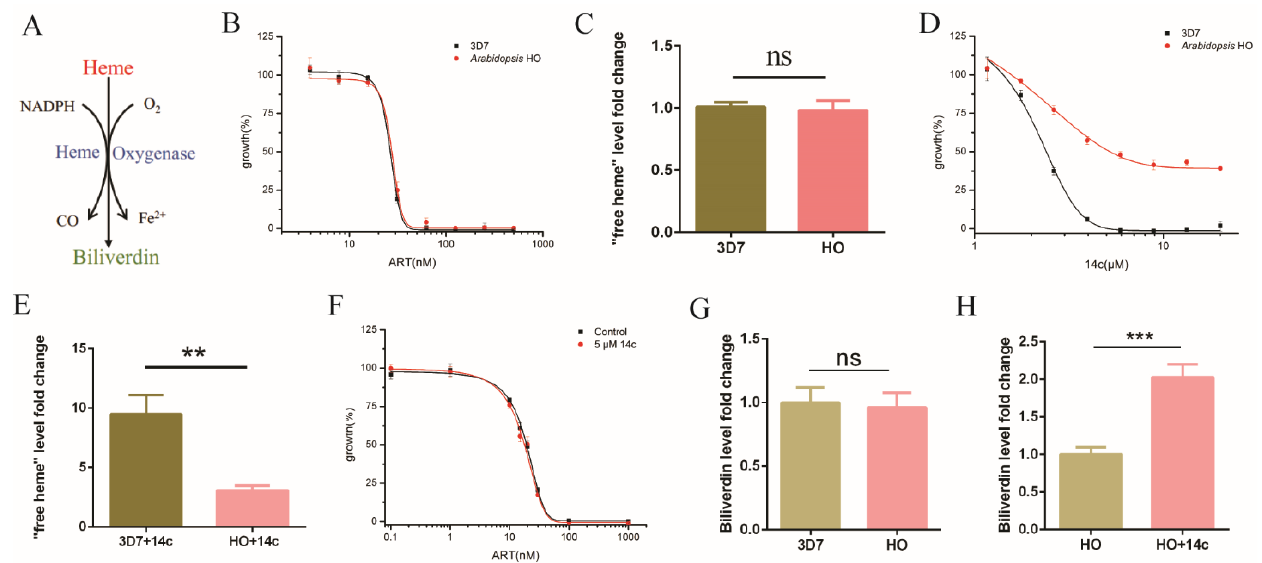
Figure 3. HO neutralized 14c’s effect on heme and artemisinin. ( A ) HO executes the heme breakdown function. ( B ) The introduction of HO did not affect the EC 50 value of artemisinin in transgenic parasites. ( C ) “Free heme” level in HO transgenic parasites had no significant change with 3D7 parasites. ( D ) HO transgenic parasites were more resistant to 14c than the wild-type parasite. ( E ) Arabidopsis HO 1 mitigated the increase in free heme by 5 μ M 14c. ( F ) HO expression in P. falciparum neutralized the antagonizing action of 14c on artemisinin. Data are mean ± SD of three experiments. ( G ) HO expression-strain-infected RBC had a similar level of biliverdin compared with 3D7-infected RBC. Data are mean ± SD of four experiments. ( H ) Treatment with 5 μ M 14c enhanced biliverdin levels in HO expression-strain-infected RBC. The data were analyzed by GraphPad Prism. ** p -value < 0.005, *** p -value < 0.0005, and ns = no significant change ( p -value > 0.05).